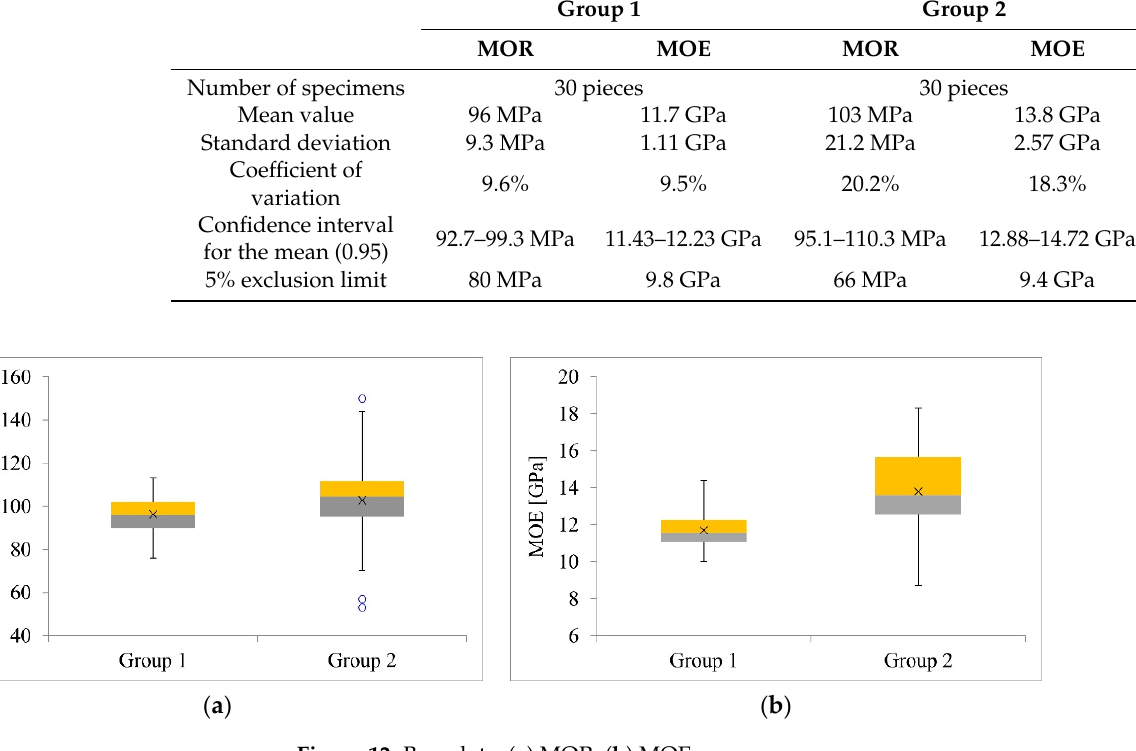
Table 14. Estimates for regression models of FF and RM with MOE as the predictor.